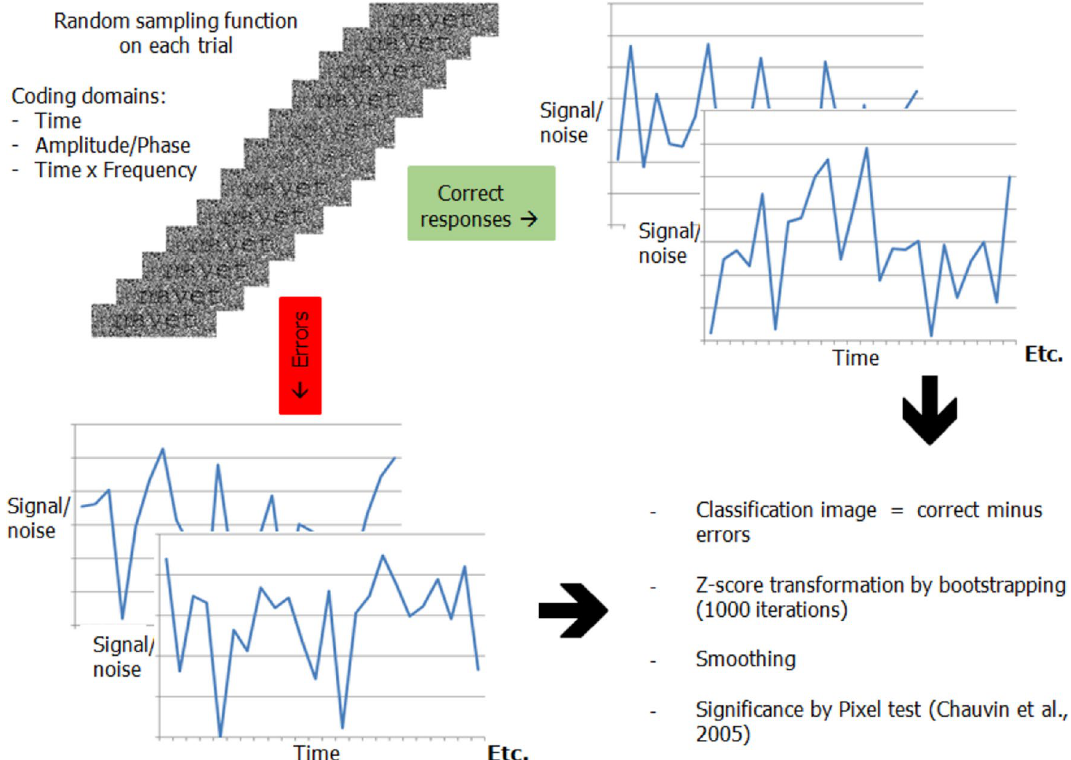
Figure 2. Illustration of the variability of the signal-to-noise ratio through time for the target word ‘navet’ (top left) and of the procedures applied to construct the classification images. The random temporal sampling functions generated on each trial were coded as either signal-to-noise ratio variations as a function of time since target onset (time domain), in terms of the amplitude and phase values of the 5–55 Hz (in 5-Hz steps) sinusoidal functions from which the temporal sampling functions were constructed (Fourier domain), or in terms of the instantaneous oscillation frequencies of the signal-to-noise ratio as a function of time since target onset (time– frequency domain). The signal-to-noise ratio vs. time sampling functions illustrated on the top right and bottom left of the figure are actual functions which were associated with either correct responses or errors in the word recognition task. The raw classification images were obtained from the weighted subtraction of the sums of the sampling functions (coded in the time, Fourier, or time–frequency domain) associated with errors from those associated with correct responses. They were then transformed into Z scores by bootstrapping, smoothing, and submitted to the Pixel test 22